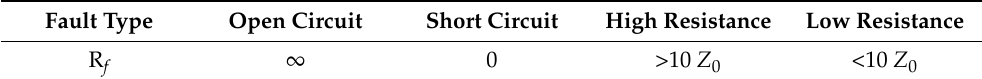
Table 1. R f values of different types of cable faults.